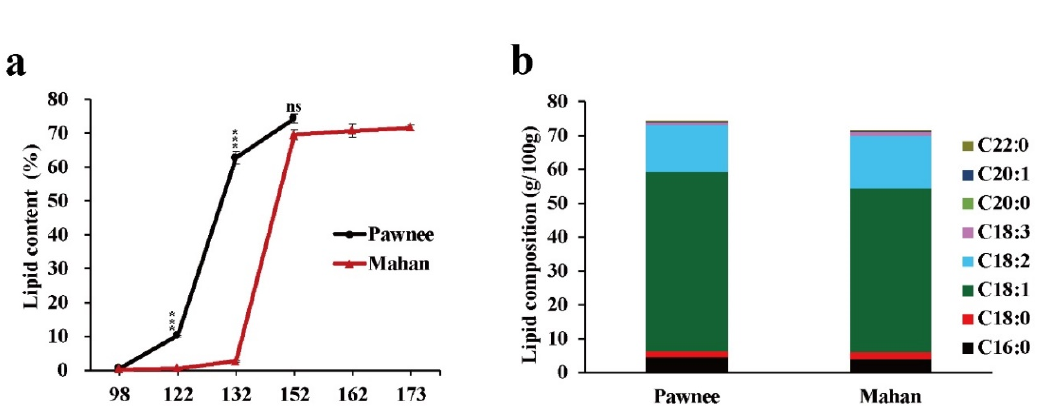
Figure 1. Fruit oil content and fatty acid (FA) composition in two pecan varieties. ( a ) Seed oil contents of early maturing Pawnee and late-maturing Mahan varieties from 98 days after flowering (DAF) to 152 DAF (Pawnee) or 173 DAF (Mahan). N = 3 for each variety and time point, and 5 g sample was used for each analysis. *** p < 0.001, Student′s t -test; ns, no significant difference. ( b ) Percentages of different FA species in seeds of Pawnee and Mahan.